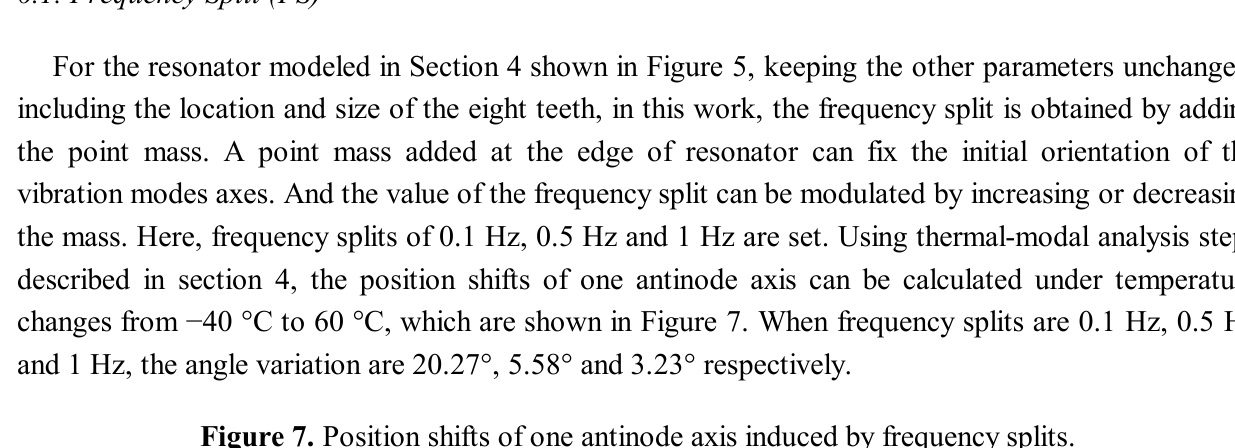
Figure 7. Position shifts of one antinode axis induced by frequency